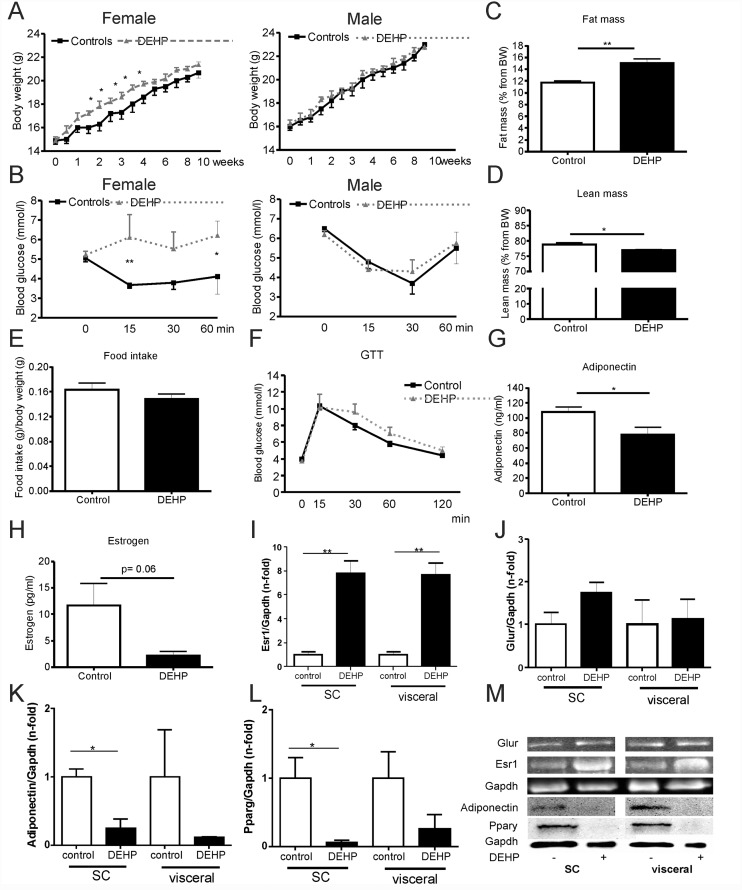

In vivo studies of 129S6 mice.
(A) Body weight gain during treatment with DEHP (B) Insulin tolerance test of 129S6 mice (N = 8 controls, N = 8 DEHP treatment) after 6 weeks of DEHP intake (C) fat mass and (D) lean mass as percent of body weight was determined in awake female mice by using nuclear magnetic resonance technology with EchoMRI700 instrument (Echo Medical Systems, Houston, TX, USA) at the end of observation period (10 weeks). Data are presented as percentage of total body fat and lean mass from body weight. Results are expressed as means ± SE from at least 5 female animals per treatment group. (E) Food intake per animal, day and body weight calculated from food intake and body weight measurements in weeks 5 and 6 of treatment. (F) ipGTT was performed on 4-h-fasted after 8 weeks of DEHP treatment in female mice. Results are expressed as means ± SE from at least 5 female animals per treatment group. (G) Serum adiponectin and (H) estrogen concentrations were analyzed at the end of observation period (10 weeks) in female mice (n = 5 per treatment group). Data are presented as mean ± SE from at least 5 female animals per treatment group. (I) Western Blot quantification of estrogen receptor protein expression (Esr1), (J) glucocorticoid receptor (Glur), Adiponectin (K) and Ppary (L) in subcutaneous (SC) and visceral adipose tissue of female 129S6 mice (at least n = 3 per experimental group). (M) Representative images in adipose tissue of control and DEHP treated mice. Equal protein loading was verified using mouse anti-D-glyceraldehyde-3-phosphate dehydrogenase (Gapdh) antibody. The different degrees of significance (t-test with Welch correction) were indicated as follows in the graphs. *p<0.05; ** p< 0.01.